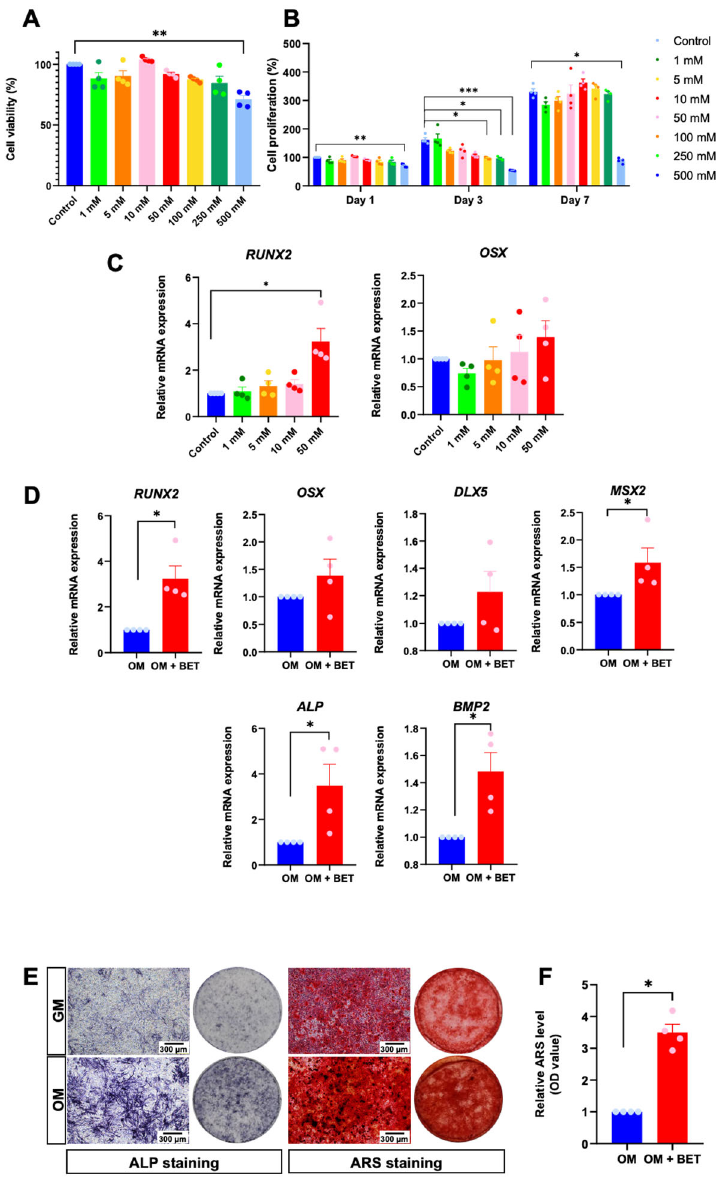
was evaluated using real-time polymerase chain reaction ( C ). Representative ALP and ARS red S staining images of ihDPs after 50 mM BET treatment for 7 and 14 days. Scale bars: 300 µm ( D ). Quanti fi cation of ARS red S staining was shown ( E ). Bars indicate a signi fi cant difference between groups (* P < 0.05, ** P < 0.01, *** P <